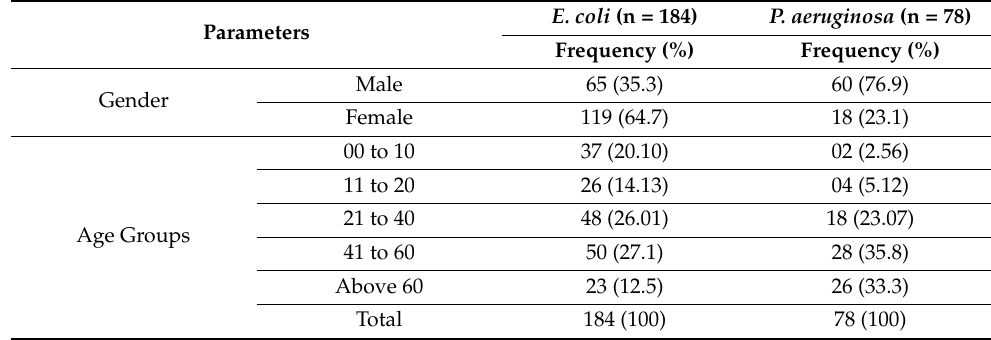
Table 1. Frequency and percentage (in parenthesis) distribution of various bacterial isolates from blood